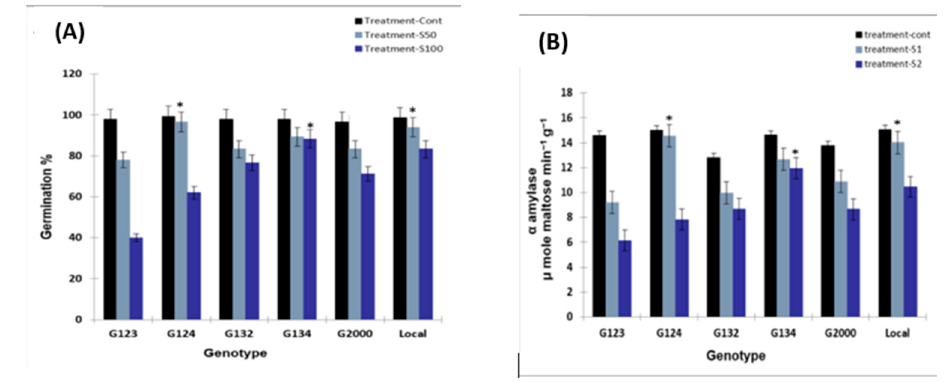
Figure 2. ( A ) Germination rate and ( B ) the reduction in α -amylase activity caused by NaCl stress. Barley seeds were germinated in 0 (control), 50 mM, and 100 mM NaCl. After treatment for 48 h, α -amylase activity was detected in 15 grains. * Means significant difference between the genotypes at probability level of 0.05.